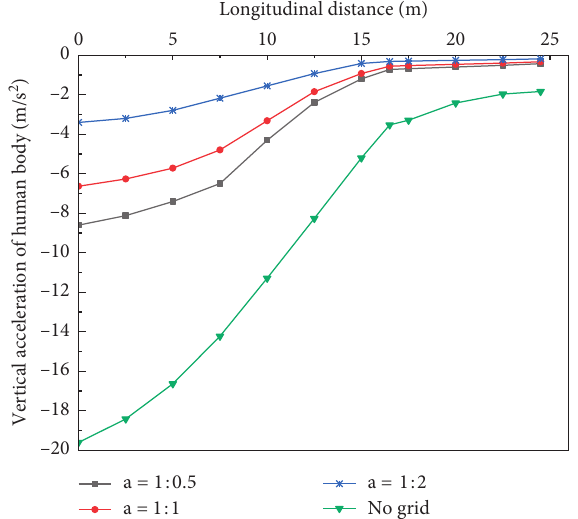
Figure 12: Settlement of the top surface of the subgrade at different grid laying